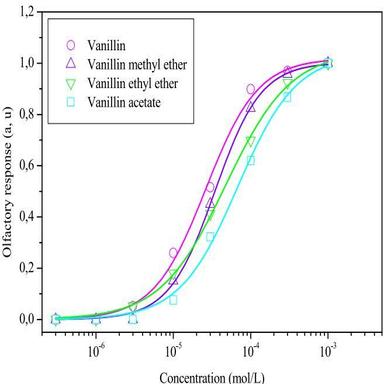
Application of the adequate statistical physics model ''the advanced monolayer adsorption model of ideal gas'' (line) on the experimental doseolfactory response curves of vanillin, vanillin methyl ether, vanillin ethyl ether and vanillin acetate on the mouse eugenol olfactory receptor mOR-EG at 310 K (symbols).